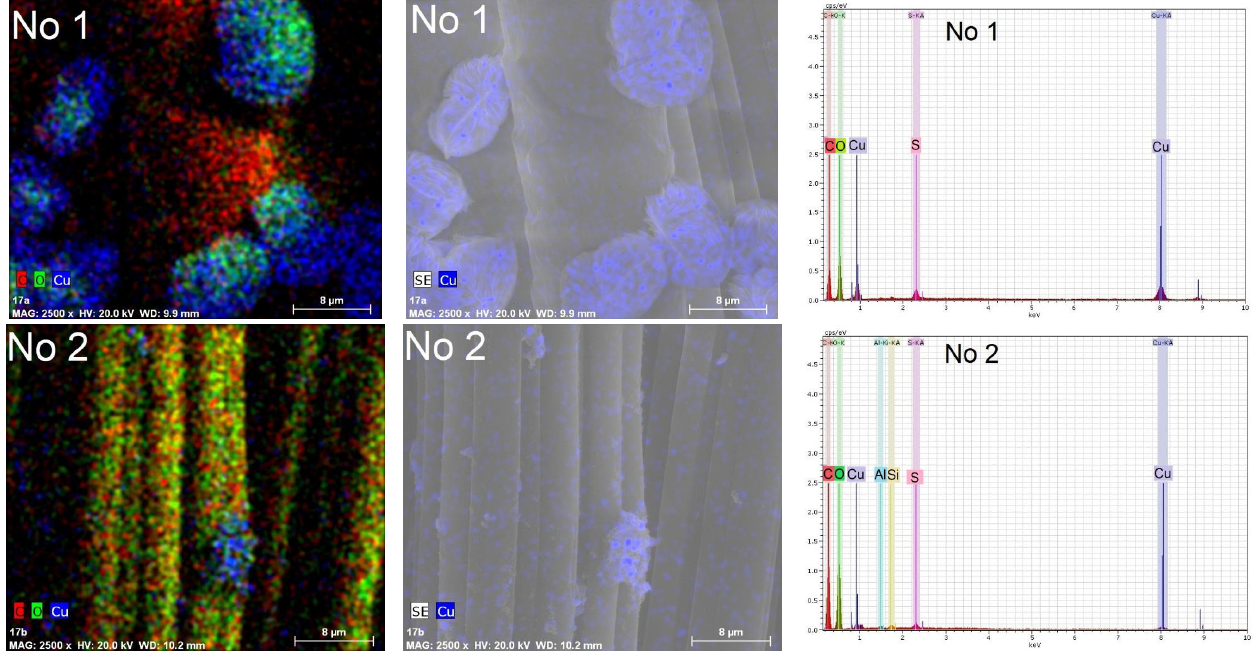
Figure 8. Chemical element maps and EDS spectra of knitted fabric materials sample O1 Materials 2022 , 15 , 7623 Figure 8 (wool/bamboo viscose, 60/40) treated with solutions No. 1 and No. 2. Magnification 2500 × .